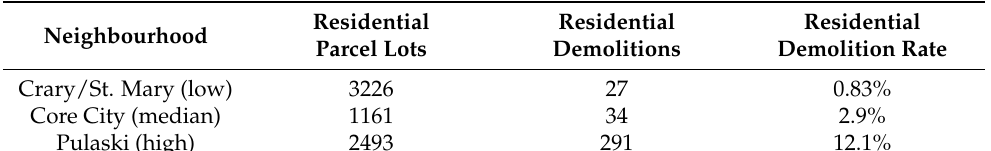
Table 2. Three chosen neighbourhoods, residential demolition rates based on Complete Residential Demolitions, City of Detroit Open Data Portal (2021a).